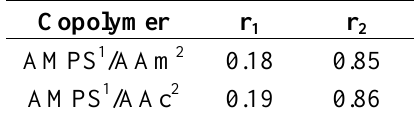
Table 5. Summary of reactivity ratio